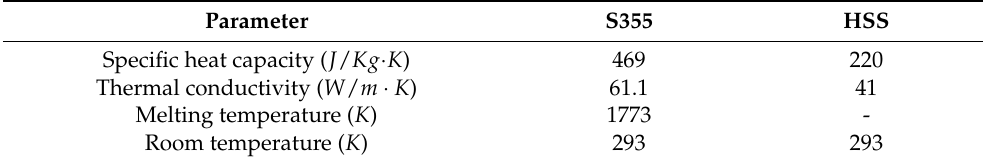
Table 2. Material thermal properties [34].